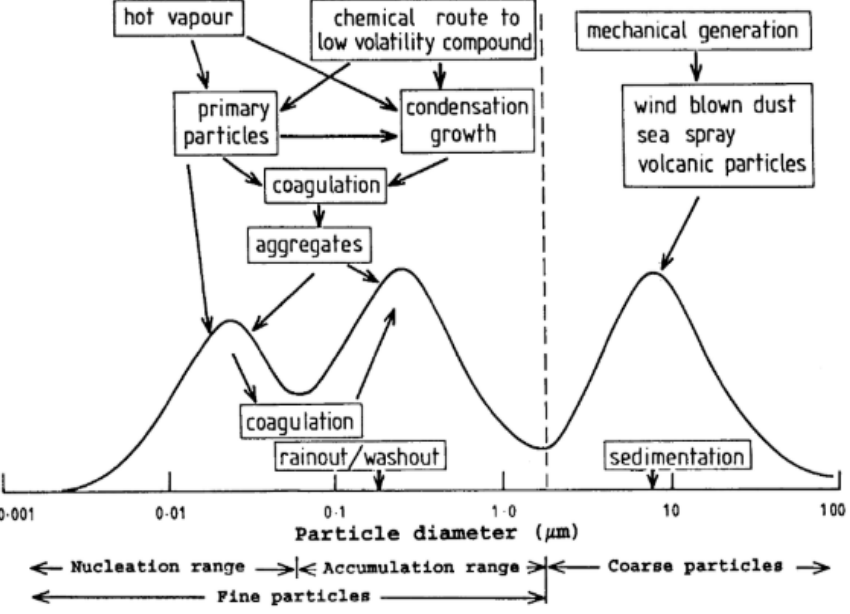
Figure 2. Schematic diagram of a typical size distribution and formation mechanisms for atmospheric particles [15].